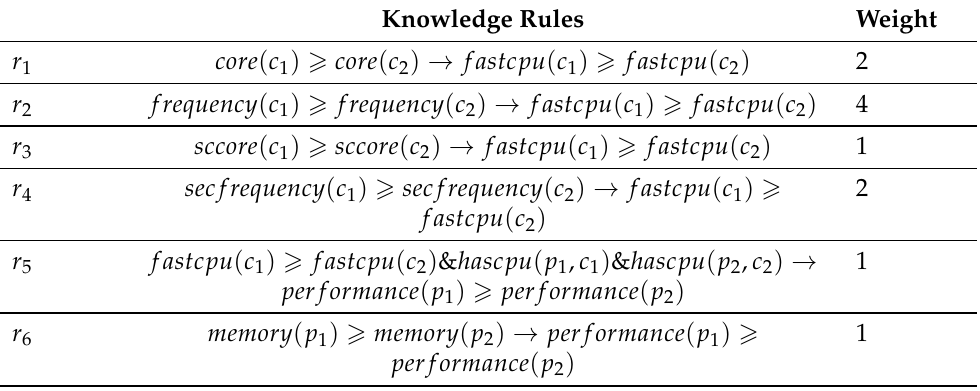
Table A1. Knowledge rules in the phone